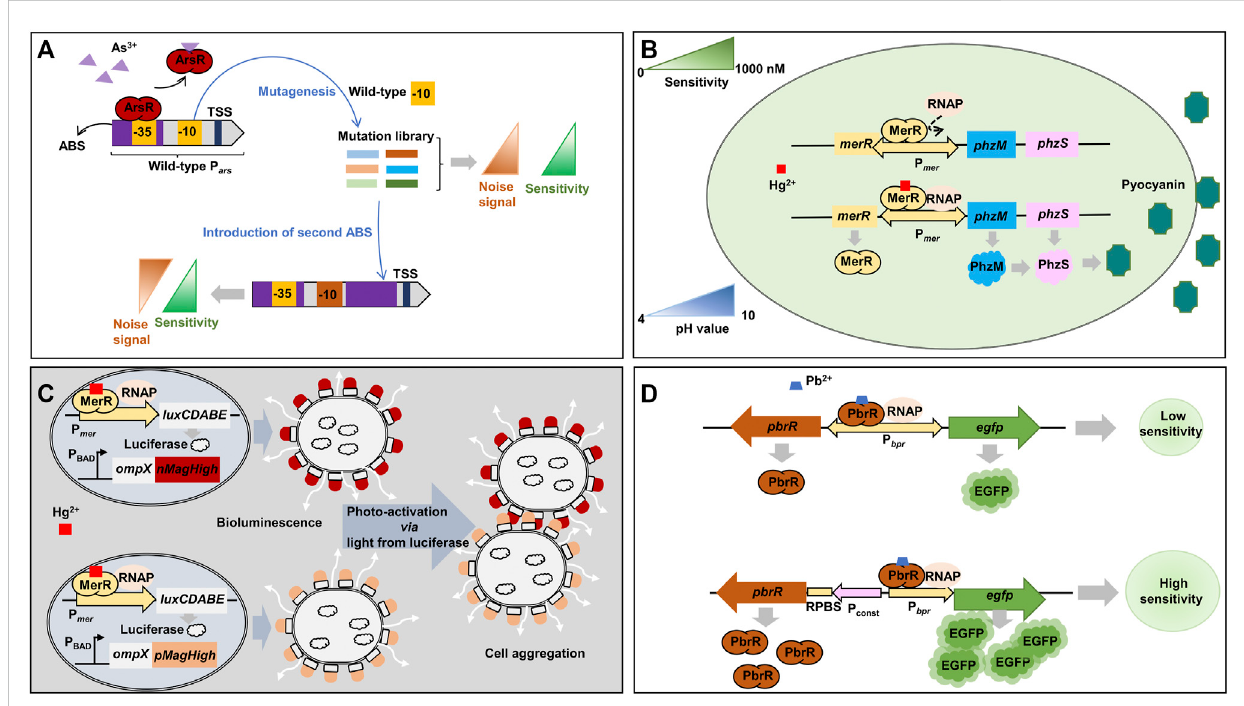
FIGURE 3 Representative synthetic biology approaches for metal-responsive transcription factor-based whole-cell biosensors. (A) Promoter engineering by screening − 10 site mutations and addition of an extra ArsR-binding site (Chen et al., 2019). (B) Use of pyocyanin, a blue-green pigment, as an optical output signal by swapping the structural genes of mer operon with pyocyanin synthesis genes (Wang et al., 2020). (C) Enhancement of bioluminescent signal by bio fi lm formation via the cell aggregation by photoswitchable proteins, nMagHigh and pMagHigh, expressed on the outer membrane (Chen et al., 2020a). (D) Optimization of heavy metal-responsive transcription factor expression to increase biosensor sensitivity (Du et al., 2019). luxCDABE : luciferase; nMagHigh : photoswitchable protein nMagHigh; ompX : outer membrane protein X; pMagHigh : photoswitchable protein pMagHigh; ABS: ArsR-binding site; RNAP: RNA polymerase; ArsR: arsenic-sensing transcriptional regulator; EGFP: enhanced green fl uorescent protein; MerR:mercury-sensing regulator; P const :moderate constitutive P558promoter; P ars :arsenic-induciblepromoter; P BAD : ara BAD operonpromoter; PbrR: lead-sensing transcriptional regulator; PhzM: phenazine-speci fi c methyltransferase; PhzS: fl avin-containing monooxygenase; P mer :